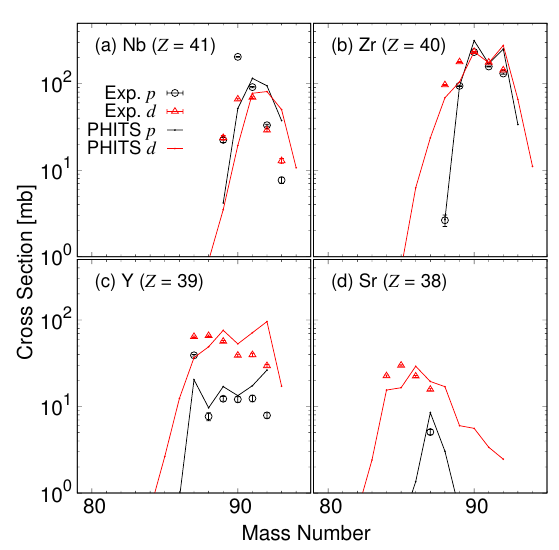
Figure 5. Comparison between the measured isotope-production cross sections and calculated cross sections with PHITS version 3.10 for p - and d -induced reactions on 93 Zr at approximately 50 MeV /